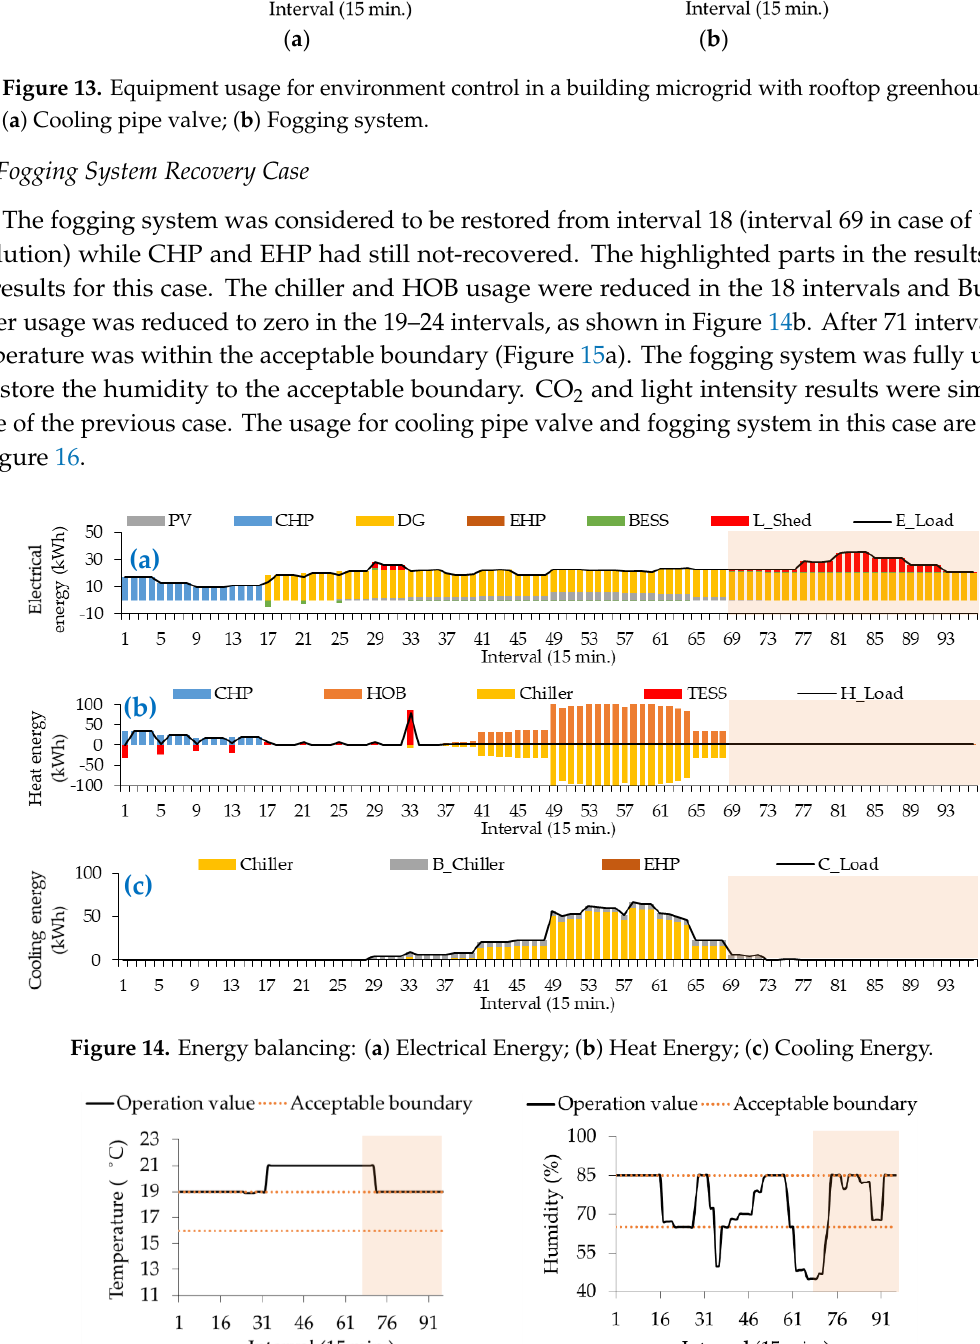
Figure 15. Environmental control of a building microgrid with rooftop greenhouse: ( a ) Temperature;